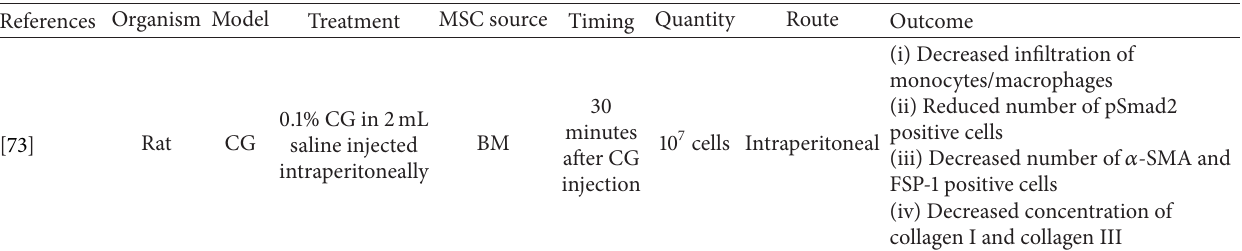
Table 5: MSC treatment on preclinical peritoneum fibrosis model.